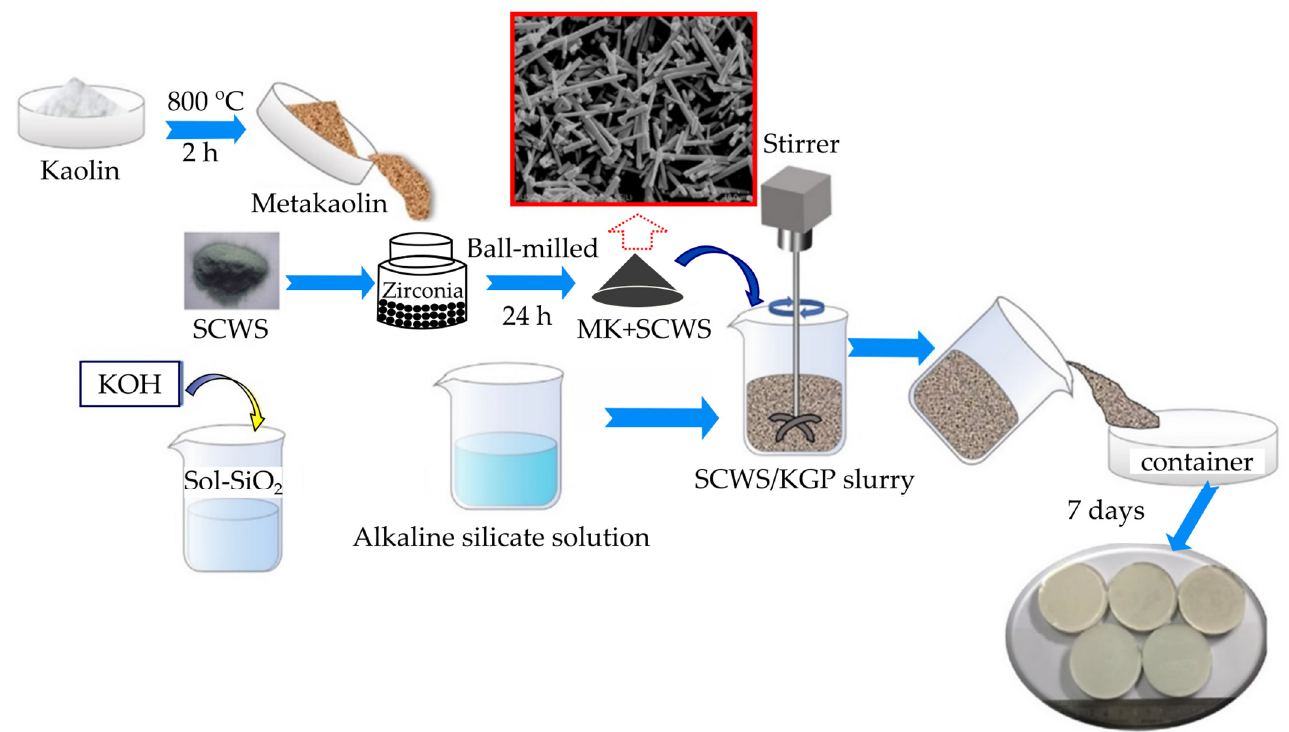
Figure 2. Preparation procedure for SCWS (SiC whiskers)/KGP (Kaolin Geopolymer) composite [46].